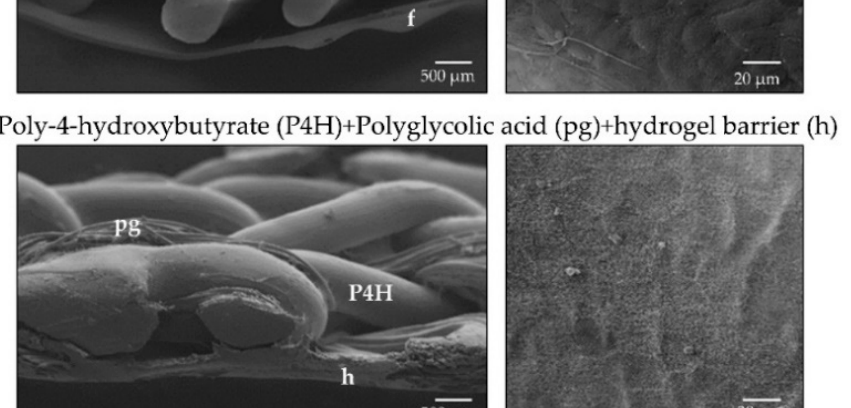
Figure 7. Scanning electron microscopy images of last generation composites ( left ) (lateral view, 50 × . Scale bar: 500 µ m) and mesothelial layer at the peritoneal side after implant ( right , 500 × . Scale bar: 20 μ m). Nowadays, there is a tendency towards the use of reticular absorbable or partially absorbable components, and a short-term (14–30 days post-implant) absorbable laminar structure as adhesion barrier.